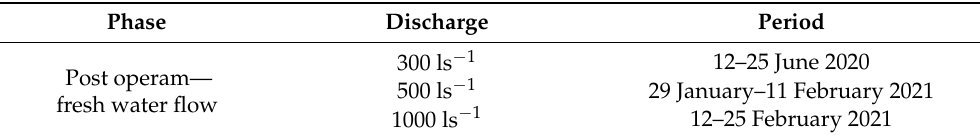
Table 3. Periods of two weeks with different regimes of fresh water discharge, during which moored probes data were comparatively evaluated.